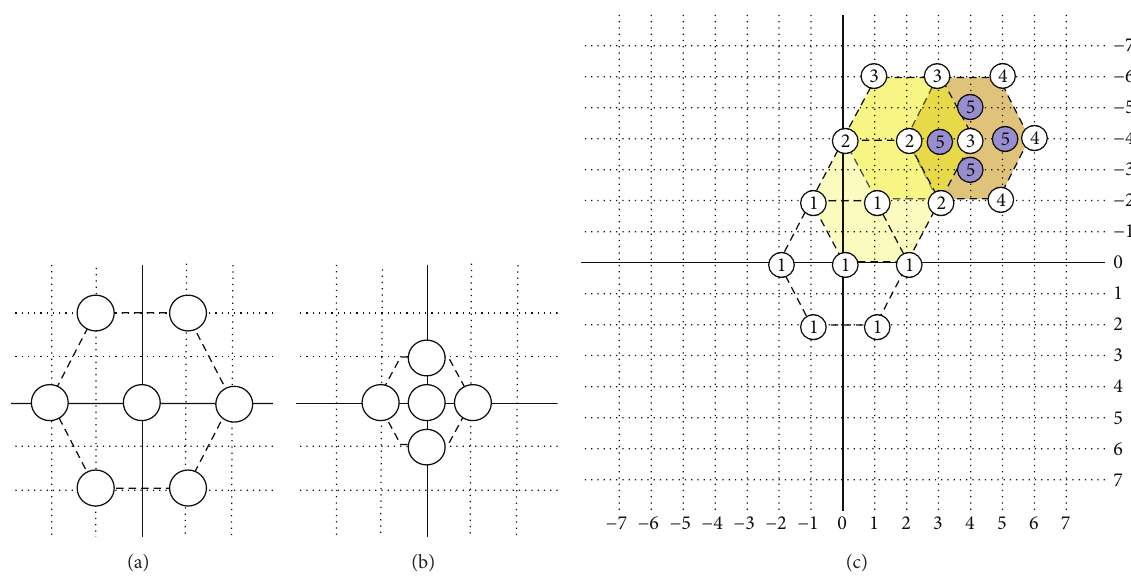
Figure 7: (a) Large HEXBS pattern. (b) Small HEXBS pattern. (c) Search path